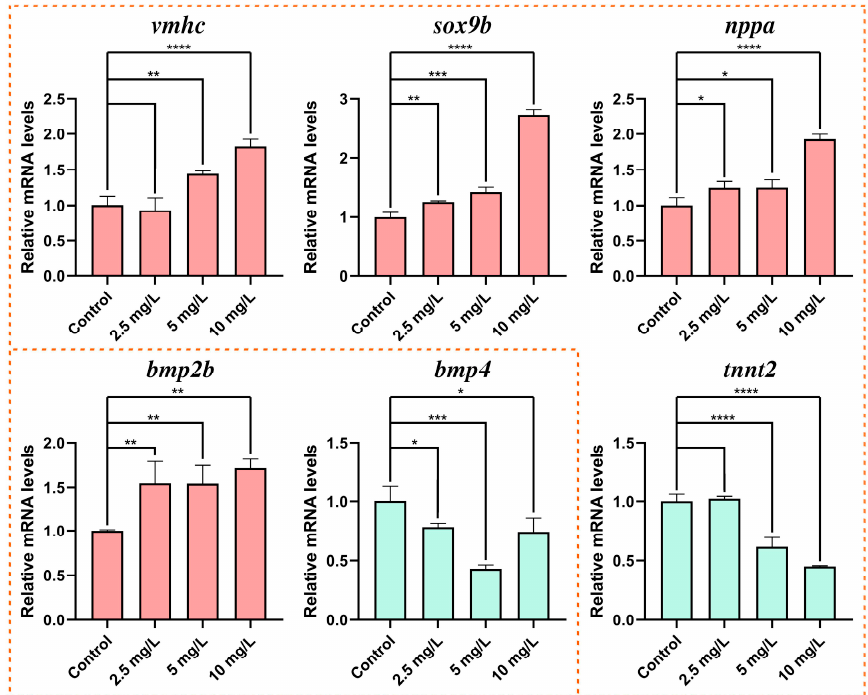
Figure 3. Expression of relative genes in heart development ( vmhc, sox9b, nppa, bmp2b, bmp4, and tnnt2 ) in zebrafish embryos. (means ± SD, * p < 0.05, ** p < 0.01, *** p < 0.001, **** p < 0.0001).